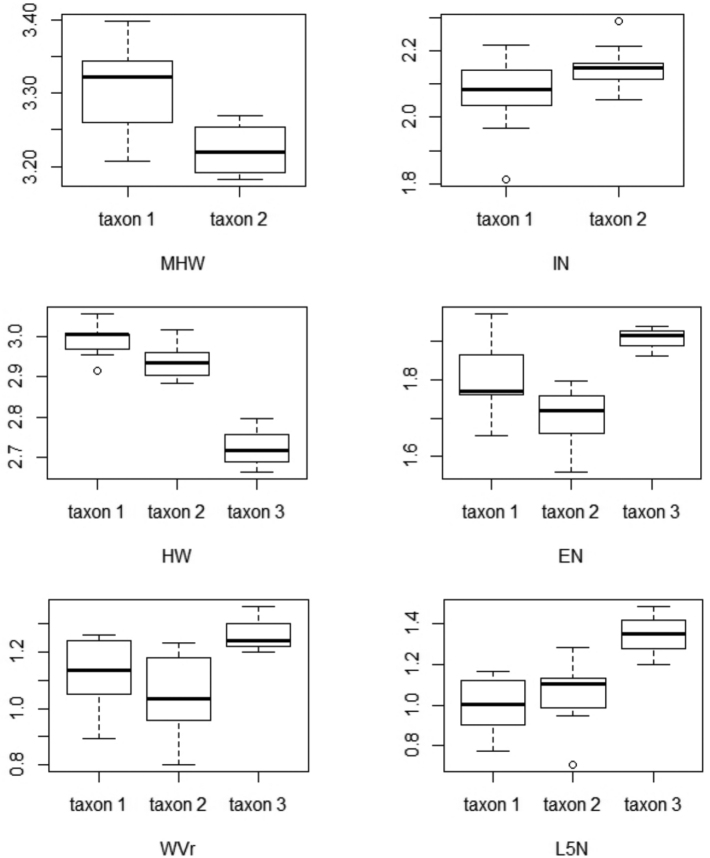
Boxplot of the most differing characters related to head and dorsal values between taxon 1, taxon 2, and taxon 3. Characters were corrected to SVL and log–transformed. For abbreviations see Materials and methods.